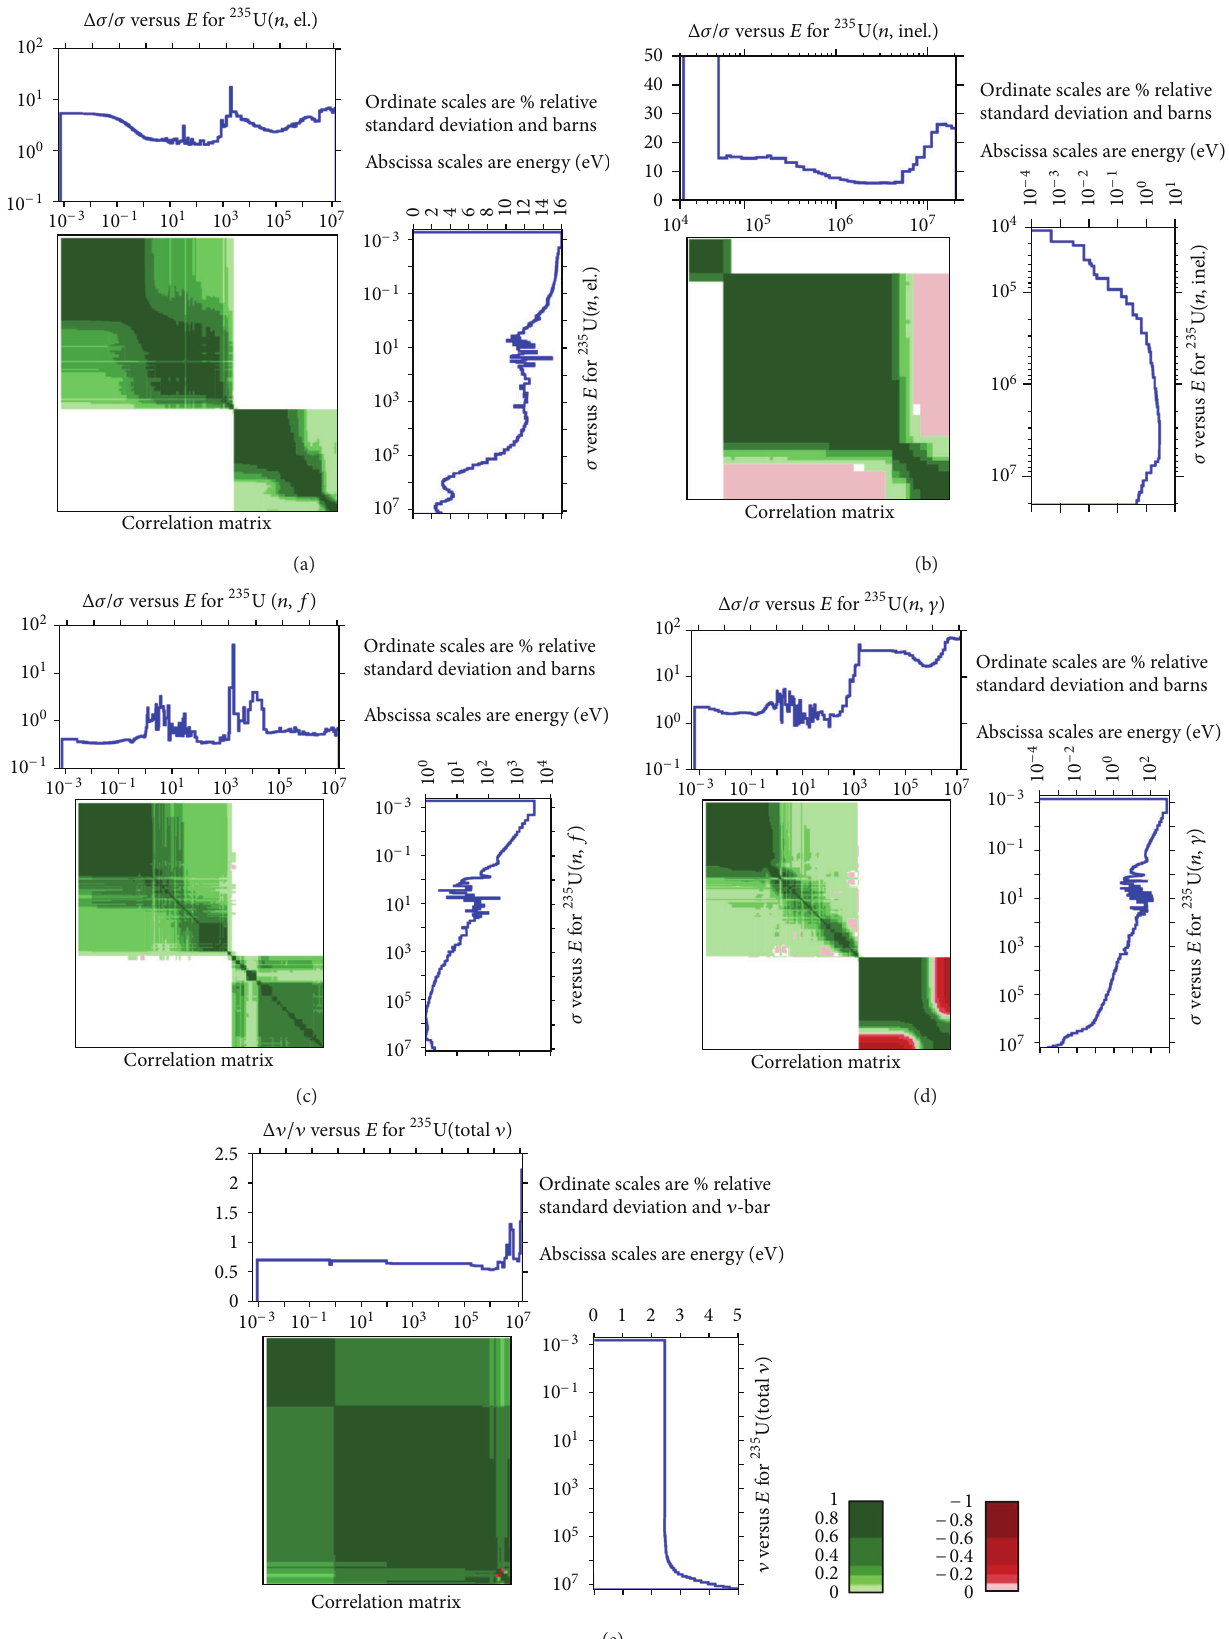
F 6: Covariance plot